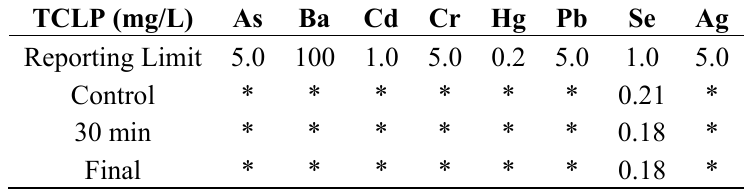
Note: * = below the lower limit of